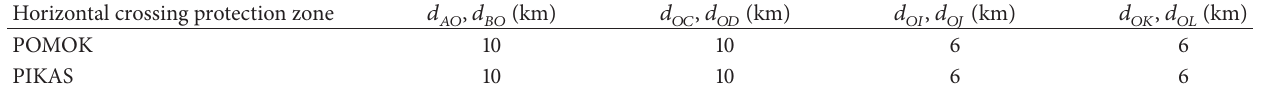
Table 2: Parameters of two special cases of type I horizontal crossing protection zone.